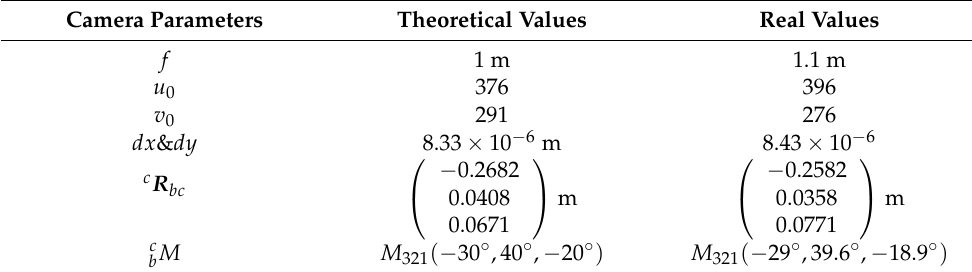
Table 2. Camera parameters.